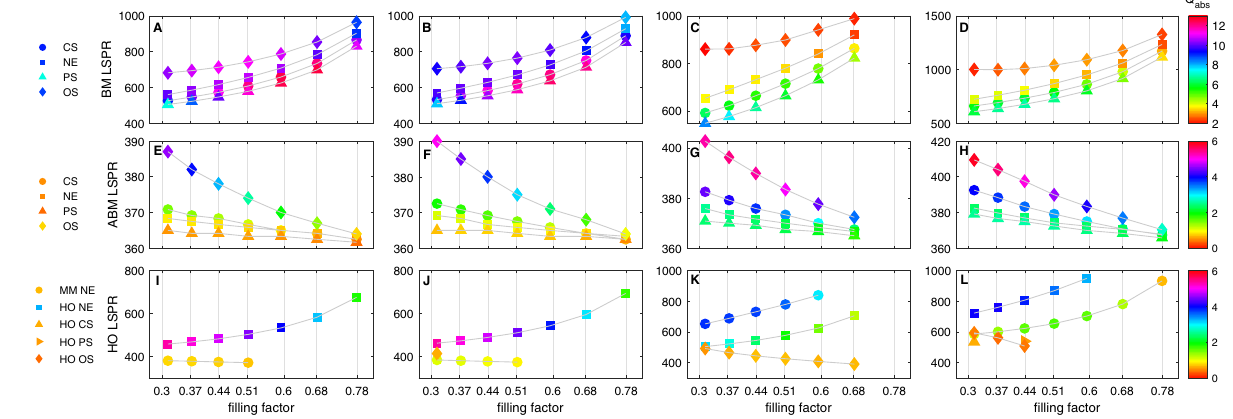
Figure 8. Effect of varying the filling factor on the (top panel) BM, (middle panel) ABM and (bottom panel) higher order; HO; LSPR wavelength and its absorption efficiency of ( A , E , I ) H 2 O@ Au 0.5 Ag 0.5 , ( B , F , J ) SiO 2 @ Au 0.5 Ag 0.5 , ( C , G , K ) Fe 3 O 4 @ Au 0.5 Ag 0.5 and ( D , H , L ) Fe 2 O 3 @ Au 0.5 Ag 0.5